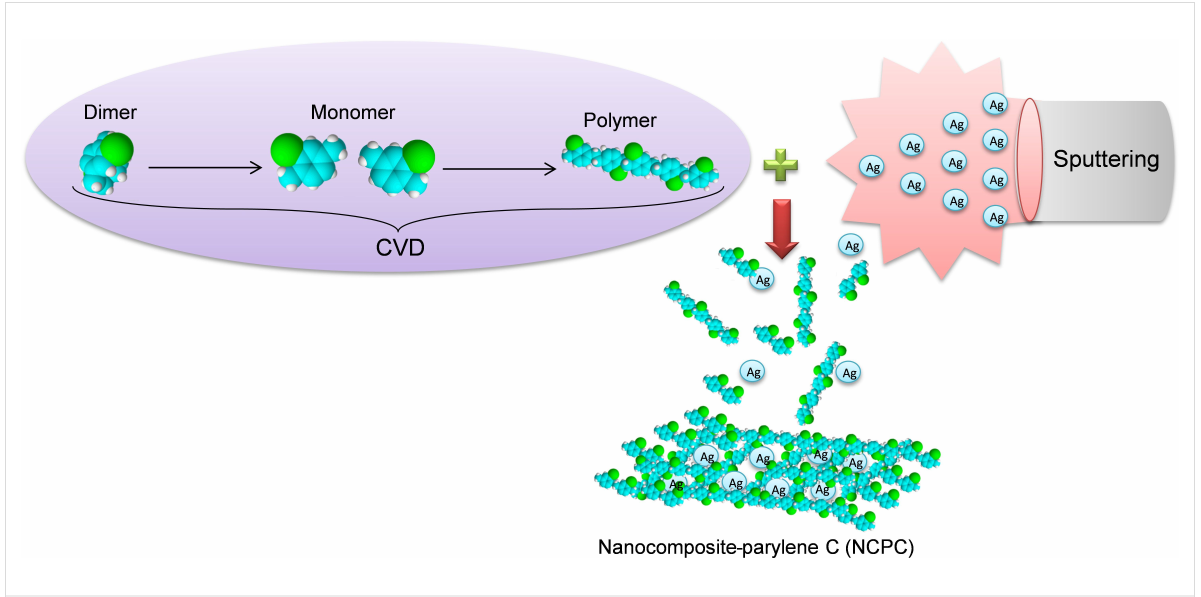
Figure 11: Depostion of nanocomposite–parylene C (NCPC) by a combined CVD and RF sputtering